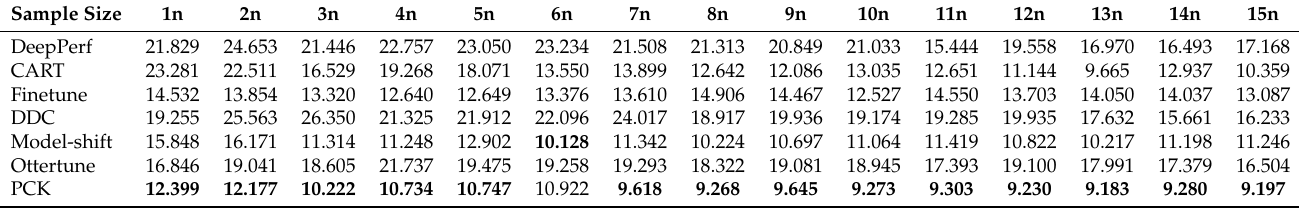
Table 2. MRE comparison among different approaches for MySQL (version 5.5–8.0). Sample Size 1n